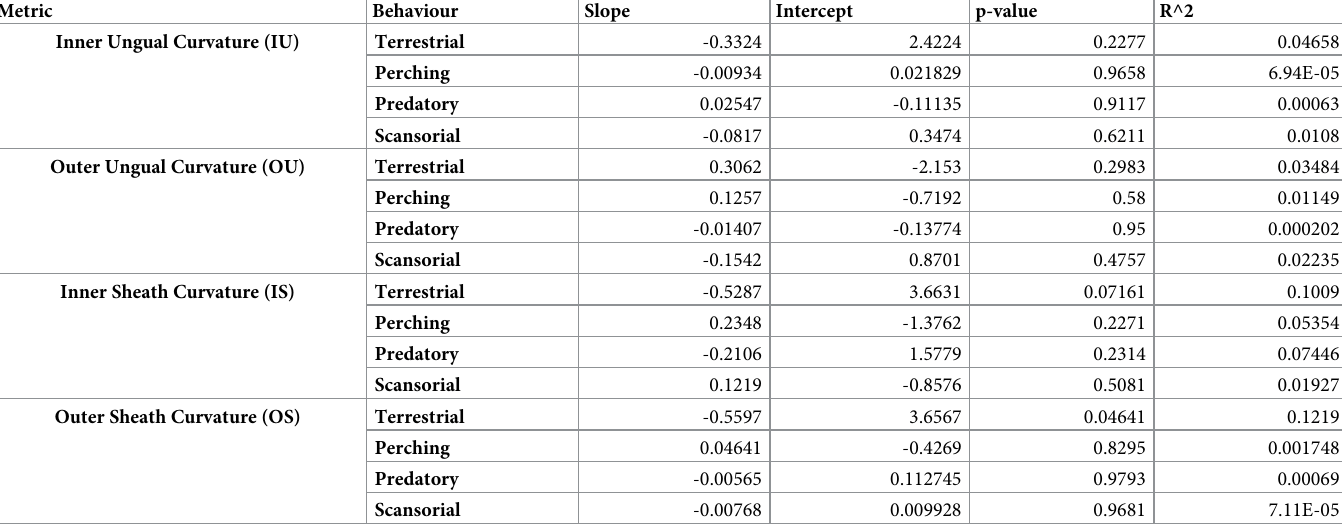
Table 1. Summary from a simple linear regression on cos(claw angle) against log(average body mass). Metric